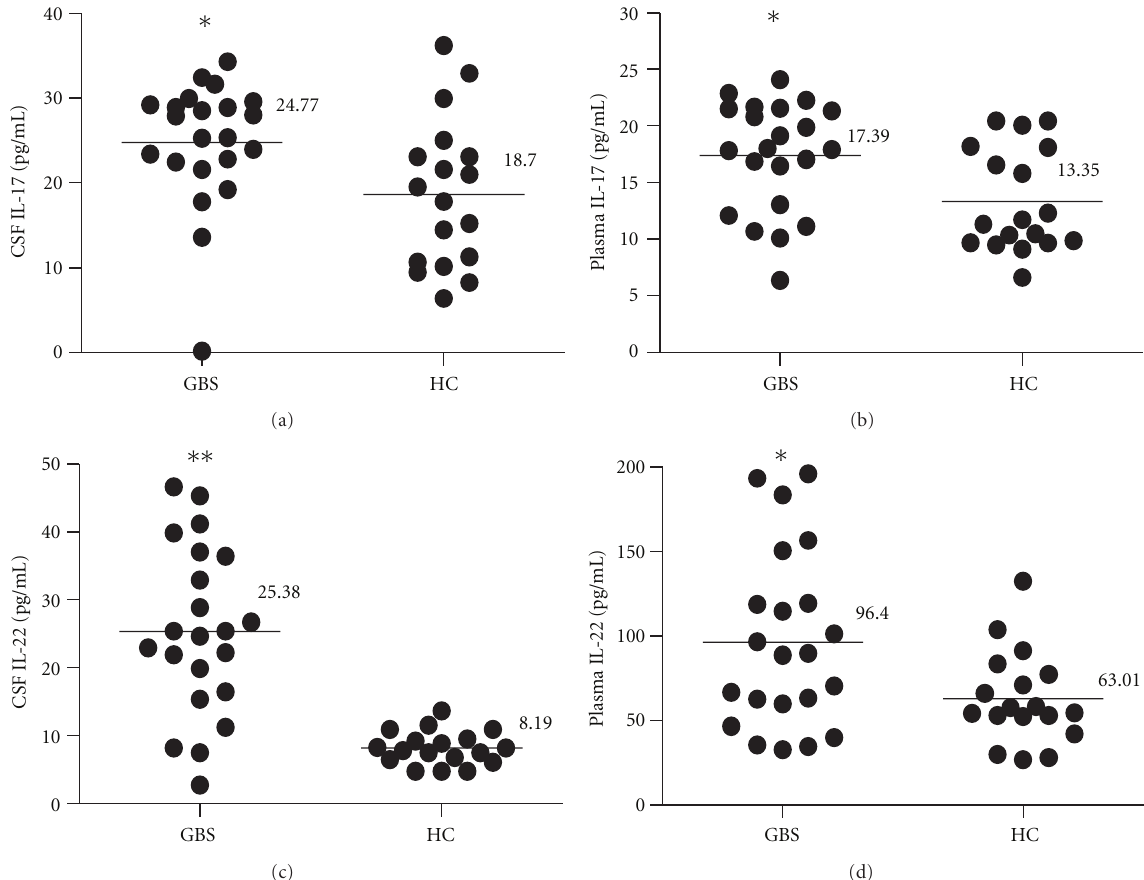
Figure 1: CSF and plasma levels of IL-17 and IL-22 in GBS ( n = 22) and healthy controls (HC, n = 18). Statistical significance was indicated: ∗ P < 0 . 05, ∗∗ P < 0 . 001. Each circle = single individual, horizontal bars = mean.